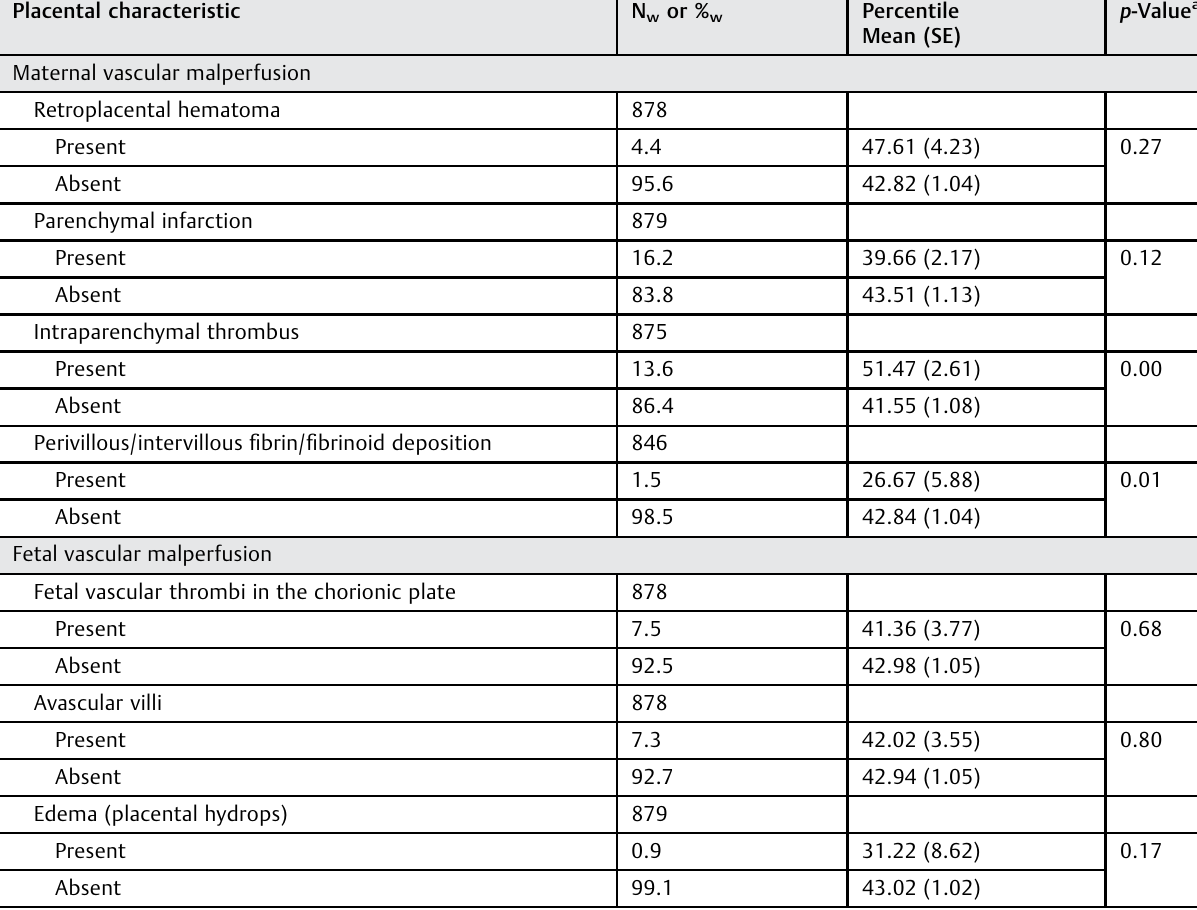
Table 3 Birth weight for gestational age percentile by presence placental characteristics related to vascular malperfusion Placental